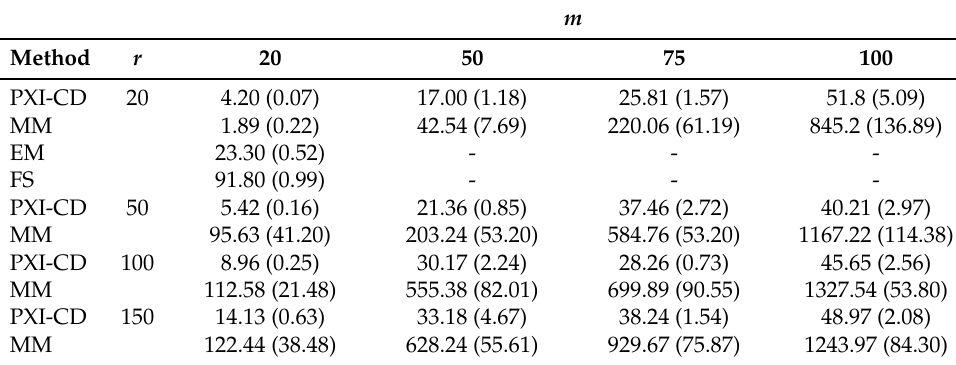
Table 1. The running times (s) when V i are low-rank, n = 1000, and γ 0 = 0.1.